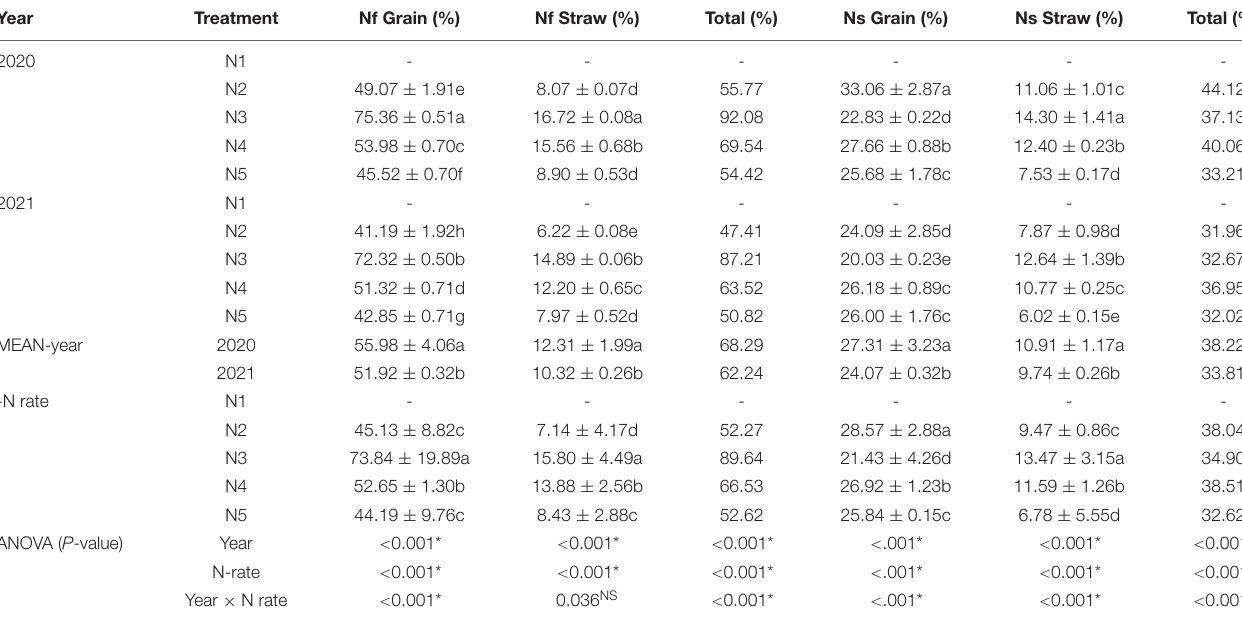
TABLE 4 | Effect of N fertilizer rates on N derived from fertilizer and soil at maturity in